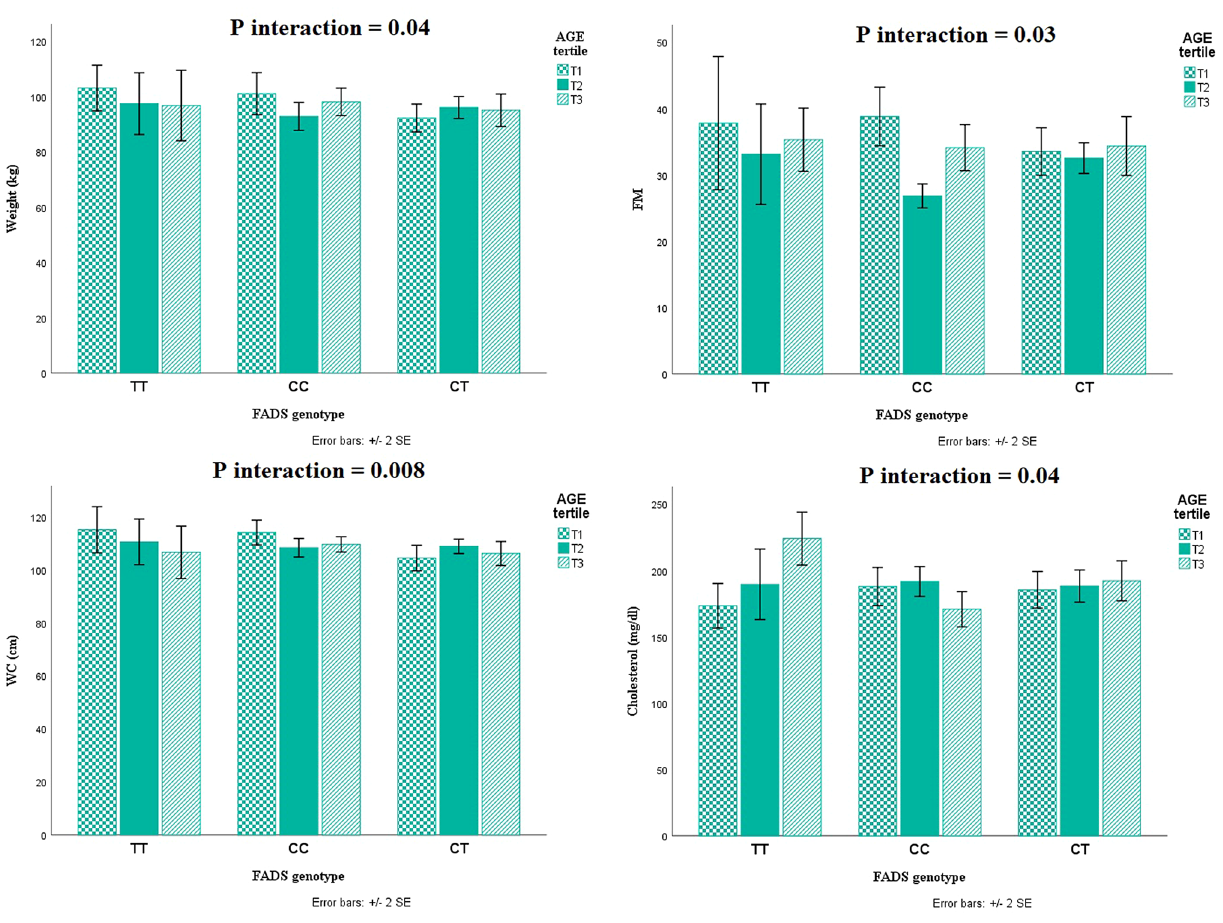
Figure 4. Interactions between FADS2 genotypes and different dietary AGEs tertiles to modify metabolic